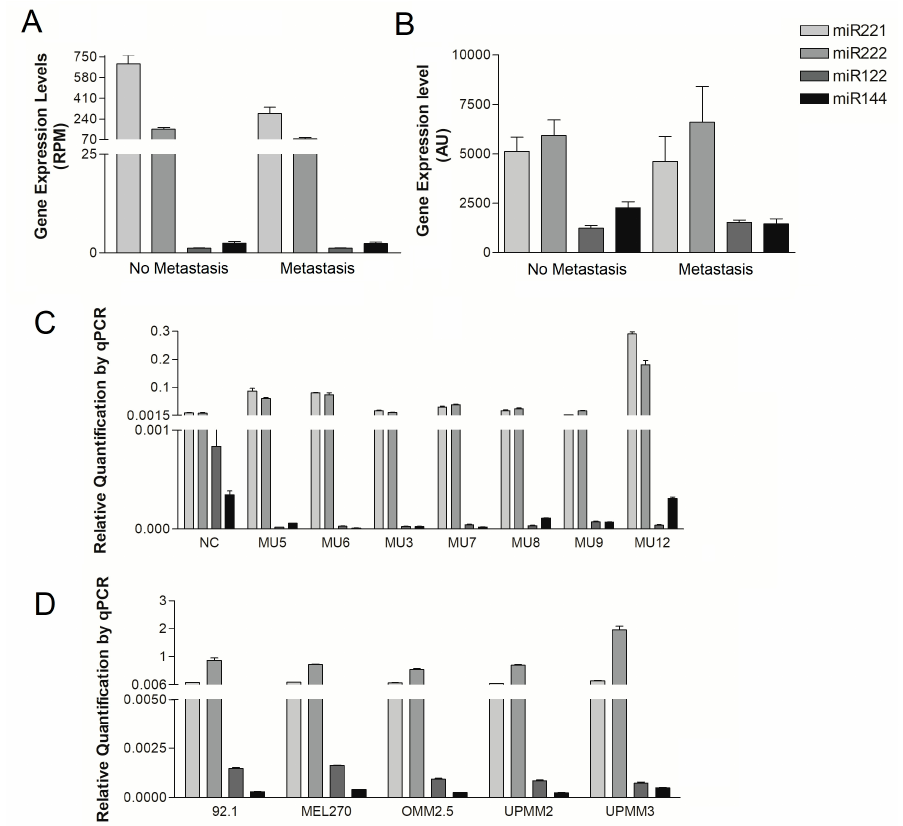
Figure 2. miR expression in UM patients and cell lines. ( A ): miR122, miR144, miR221 and miR222 expression in 78 UM from the TCGA: 52 UM were non-metastatic and 26 were metastatic. MiR levels are expressed as log2 (total_RPM + 1) transformed. RPM: reads per million reads. ( B ): miR122, miR144, miR221 and miR222 expression in 19 primary UM, of which 5 were metastatic and 14 non-metastatic. Microarray data show miRNA normalized and log2 transformed of the fluorescence intensity (AU) (miR122 p = 0.66 and miR144 p = 0.77). ( C ): miR122, miR144, miR221 and miR222 expression in normal choroid (NC) and 7 UM using RT-qPCR. Only UM 5 and 6 were non-metastatic. Expression of miR122 and miR144 was lower in UM samples than in normal choroid. Data are presented as relative quantification analysis (1/delta Ct) with efficiency-method, compared to the U6 internal control. Values are the mean ± sd of n = 3 independent RT-qPCR analyses. ( D ): expression of miR122 and miR144 was measured in a panel of 5 UM cell lines using RT-qPCR. Data are presented as relative quantification analysis with efficiency-method, compared to the U6 internal control. Values are the mean ± sd of n = 3 independent RT-qPCR analyses. Light gray bars = miR221, gray bars = miR222, dark gray bars = miR122 and black bars = miR144.